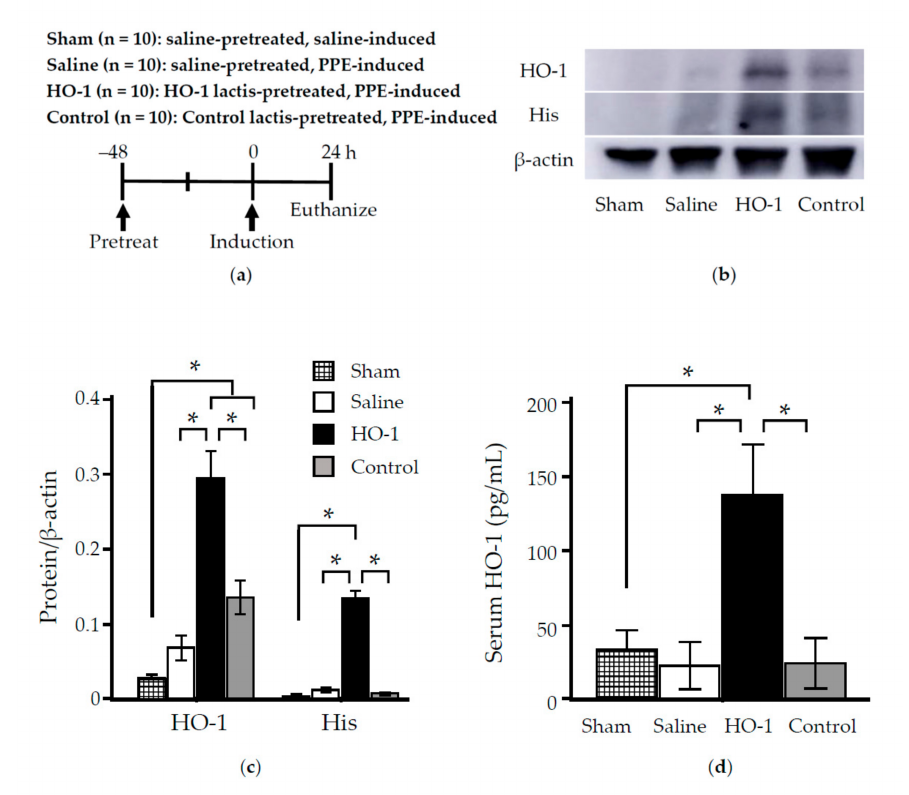
Figure 5. E ff ect of nasal administration of HO-1 lactis on protein expression in the lungs and serum in mice with porcine pancreatic elastase (PPE)-induced emphysema. ( a ) Experimental schedule and group designations. ( b ) Lung homogenates collected 24 h after PPE induction (i.e., 72 h after pretreatment with HO-1 lactis) were examined by Western blotting using anti-His tag Ab and anti HO-1 Ab. ( c ) Bands corresponding to either HO-1 or His-tag protein normalized to β -actin were analyzed. Densitometric analysis of band intensity representing the mean ± SE of 2–3 independent experiments involving total 5 mice / group. ( d ) Serum HO-1 was determined by ELISA. Results represent the mean ± SE of 2 independent experiments involving a total 5 to 6 mice / group. * p <